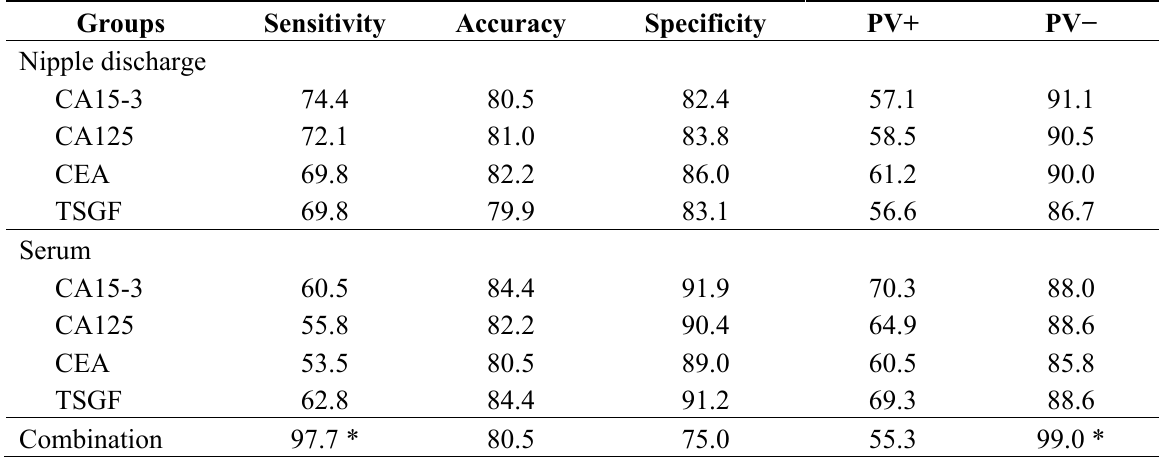
Table 2. The diagnostic discriminative value of the four biomarkers in breast cancer (%).